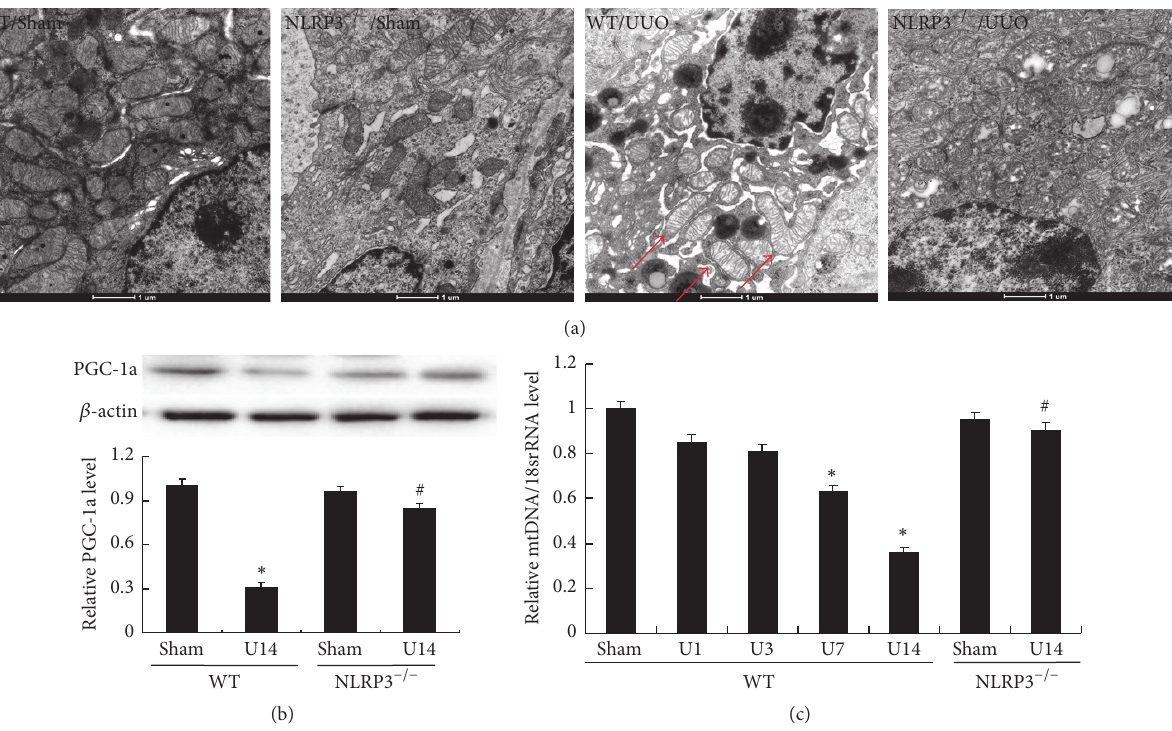
Figure 7: NLRP3 deletion reverses UUO-induced mitochondrial dysfunction. Representative electron microscopy photomicrographs of ultrastructural morphology of mitochondria (a), (magnification × 12,000). Arrow indicates swollen mitochondria. Expression of PGC-1a in kidney sample was detected, and semiquantitative analysis of PGC-1a normalized against 𝛽 -actin (b). Semiquantitative analysis of mtDNA expression normalized against 18S performed by real-time PCR (c). Data represent the mean ± SEM ( 𝑛 = 6 ). ∗ 𝑃 < 0.05 , compared with WT/Sham group, # 𝑃 < 0.05 , NLRP3 −/− /U14 group versus WT/U14 group. U1, U3, U7, and U14 indicate that mice were sacrificed on days 1, 3, 7, and 14 after